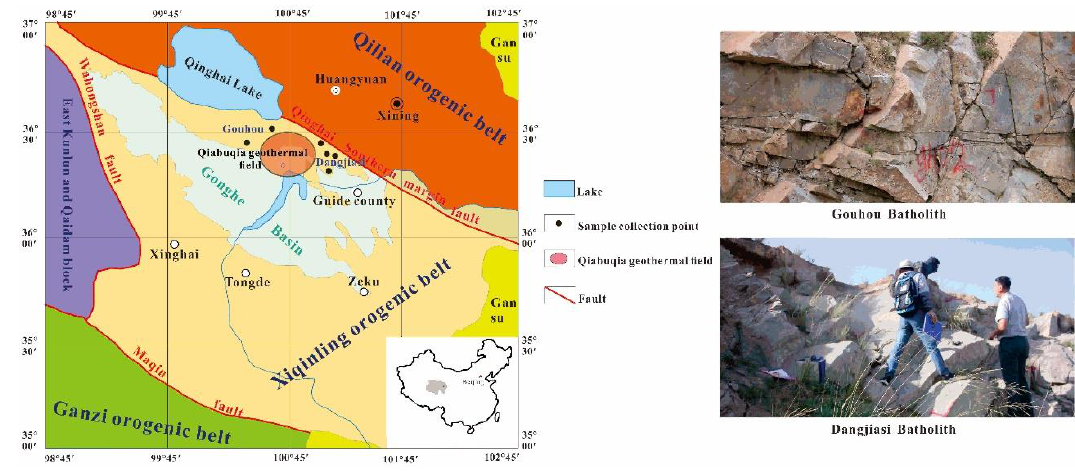
Figure 1. Geological setting of Qiabuqia geothermal field ( Left ) and the target batholith ( Right ).